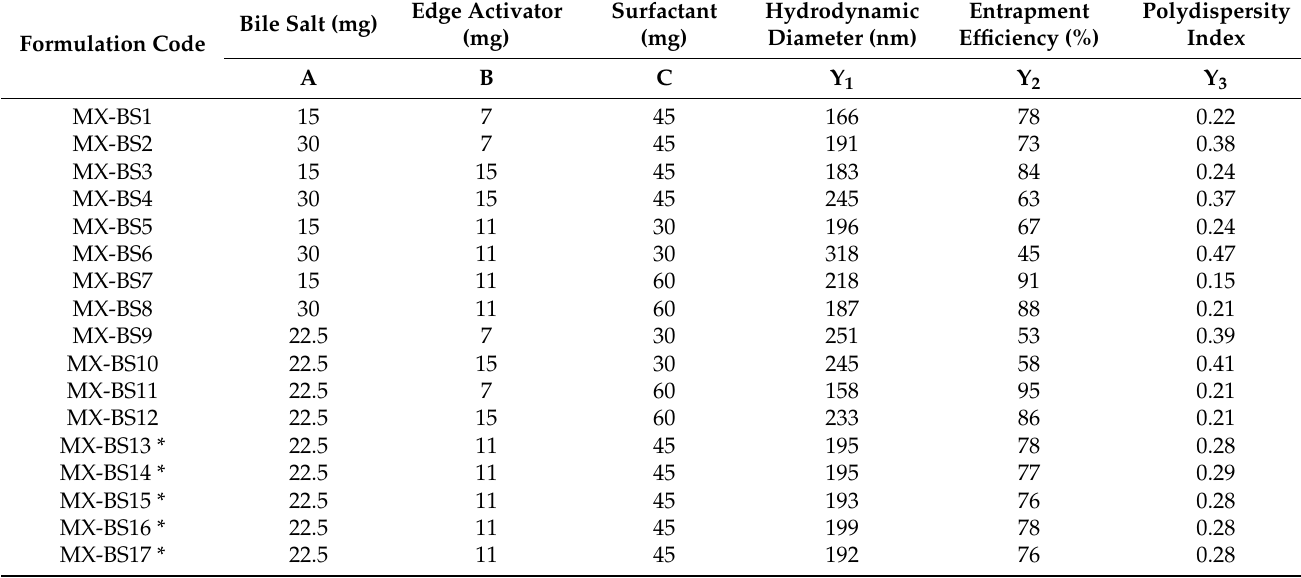
Table 1. Formulation composition of moxifloxacin bilosomes and data of